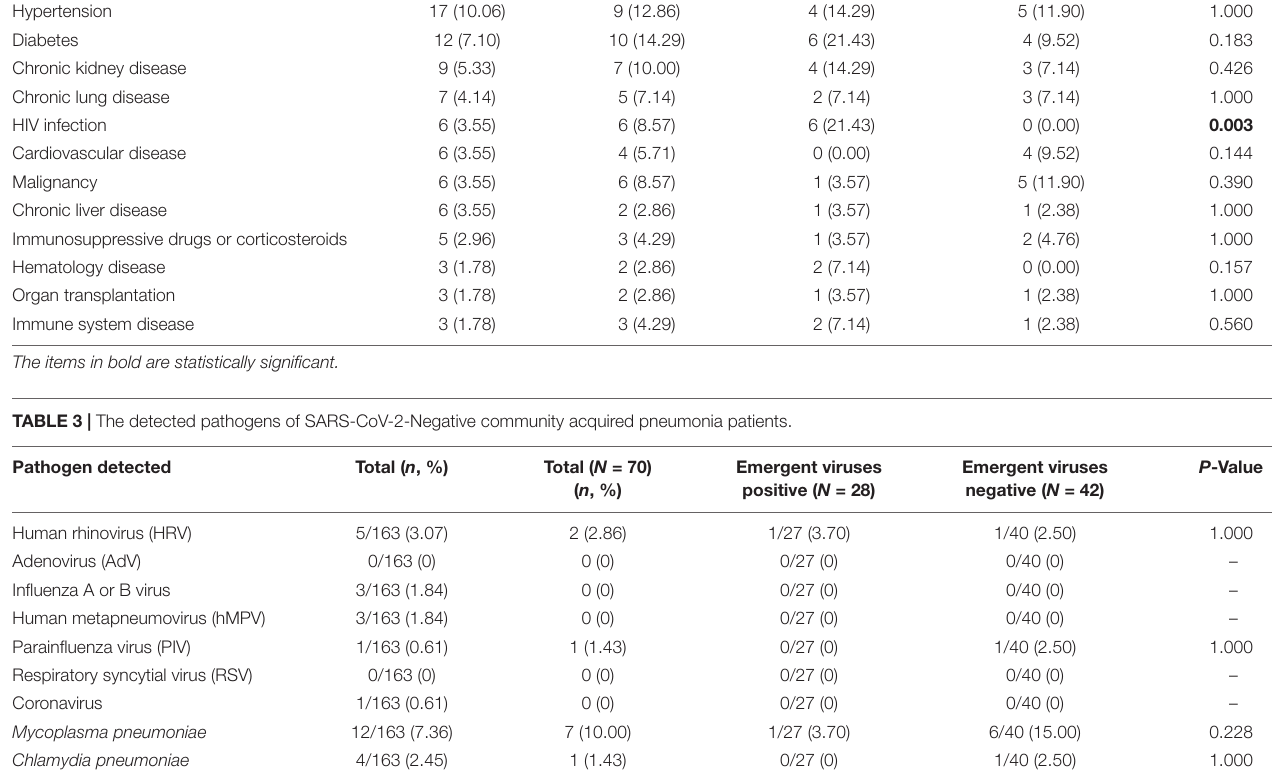
TABLE 2 | The underlying diseases and risk factors of SARS-CoV-2-Negative community acquired pneumonia patients. Underlying diseases and factors